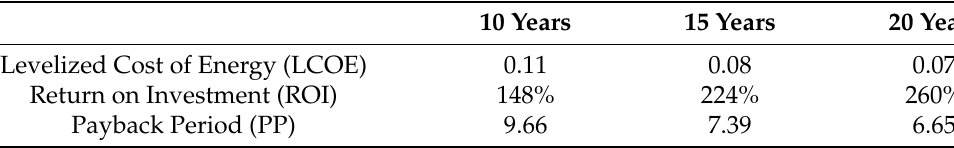
Table 9. PV energy-Cost